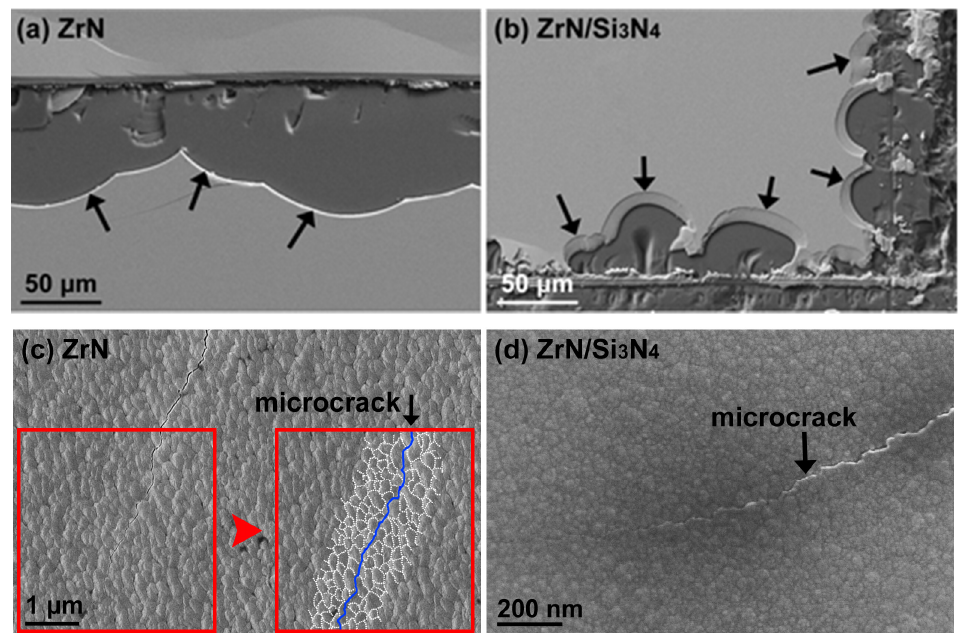
Figure 7. SEM images of the cracking behaviors of the ZrN and ZrN/Si 3 N 4 coatings that are produced by the revetest scratch test: ( a , b ) show the scratch tracks formed the ( a ) ZrN and ( b ) ZrN/Si 3 N 4 coatings, respectively; ( c , d ) illustrate higher magnification images of the microcrack tip on the ( c ) ZrN and ( d ) ZrN/Si 3 N 4 coatings, respectively.